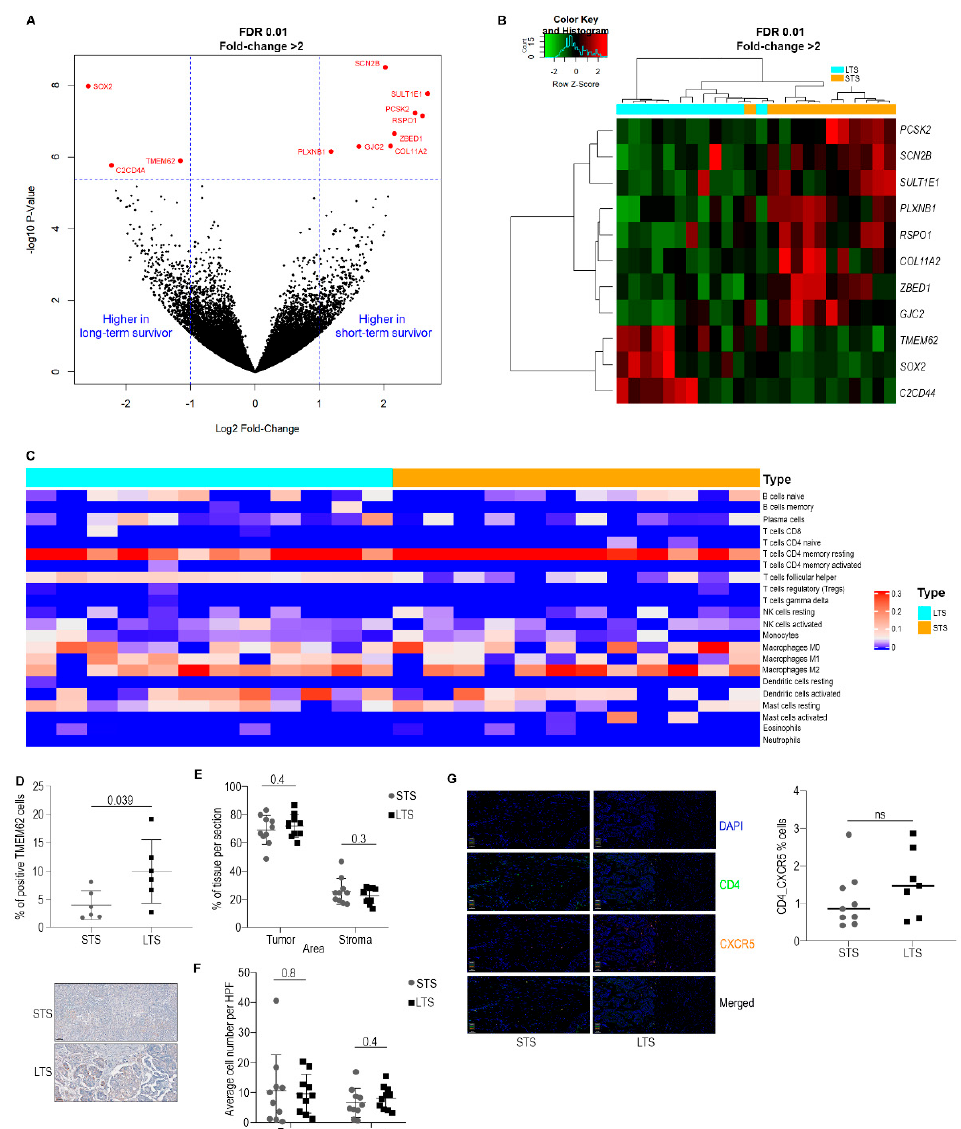
Figure 1. Molecular analysis of high-grade serous ovarian carcinoma (HGSC) samples from patients with long-term survival (LTS) or short-term survival (STS). ( A ) Volcano plot from RNASeq data showing the genes with highest expression in both groups. ( B ) Heat map showing the expression levels of genes highly expressed in LTS. ( C ) CIBERSORT analysis from patients with LTS or STS. ( D ) IHC validation of higher expression of TMEM62 in the LTS group. Top: IHC quantification using Visiopharm. Bottom: Representative images of LTS and STS groups stained with TMEM62 antibody. Scale: 50 μ m ( E ) Percentages of tissue area (tumor and stroma). ( F ) Number of infiltrating CD8 cells per tissue area. ( G ) Percentage of positive T FH per group. Right: OPAL staining using CD4 and CXCR5 antibodies. Left: Percentage of positive double stained cells in the whole tissue area.